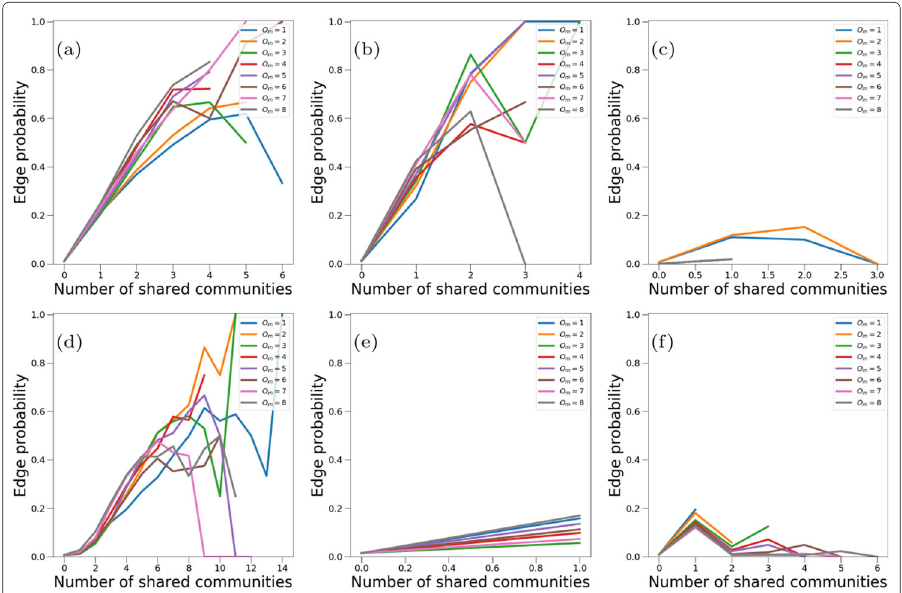
Fig. 5 Variation of the maximum number of memberships ( O m ) for LFR synthetic networks considering the edge probability: a Bigclam; b CFinder; c Copra; d Demon; e SLPA; f